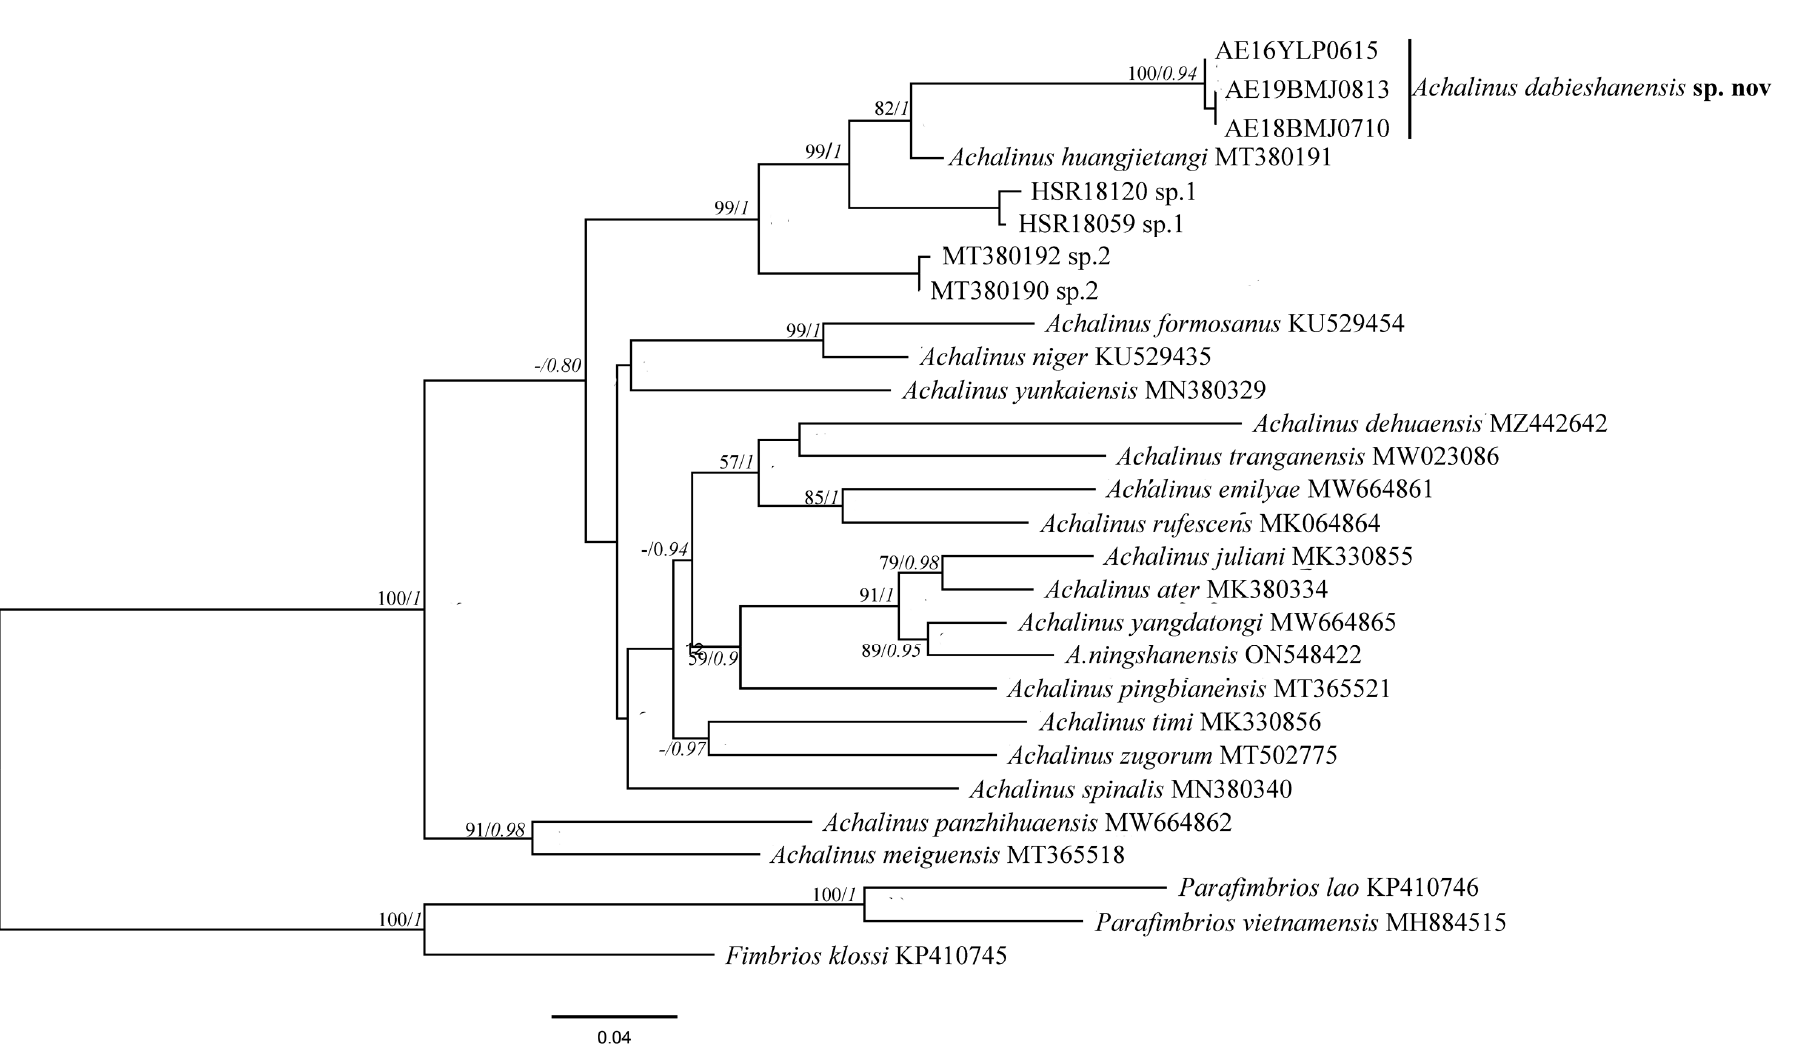
Figure 1. Maximum likelihood (ML) tree of the genus Achalinus reconstructed based on DNA sequences of segments of the COI genes. ML bootstrap support/Bayesian posterior probability is denoted beside each node, and the symbol “‑” indicates values below 50%. Sample information is provided in Table